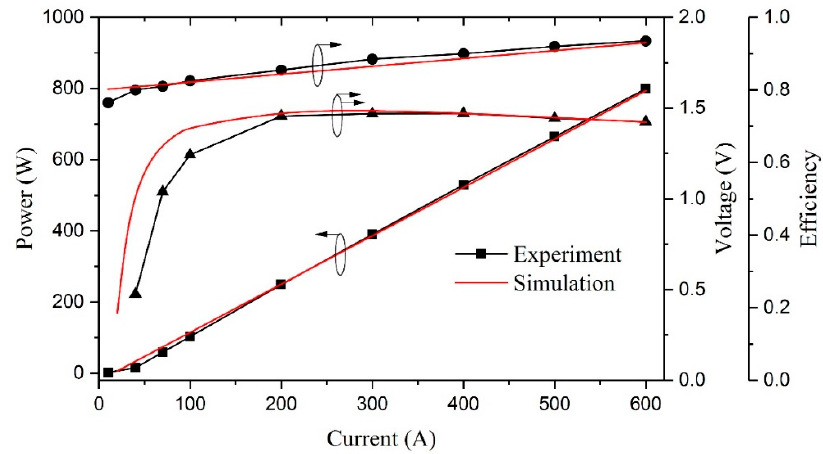
Figure 9. Contrast of simulated and experimental L-I-U curves of laser bars at 223 K.